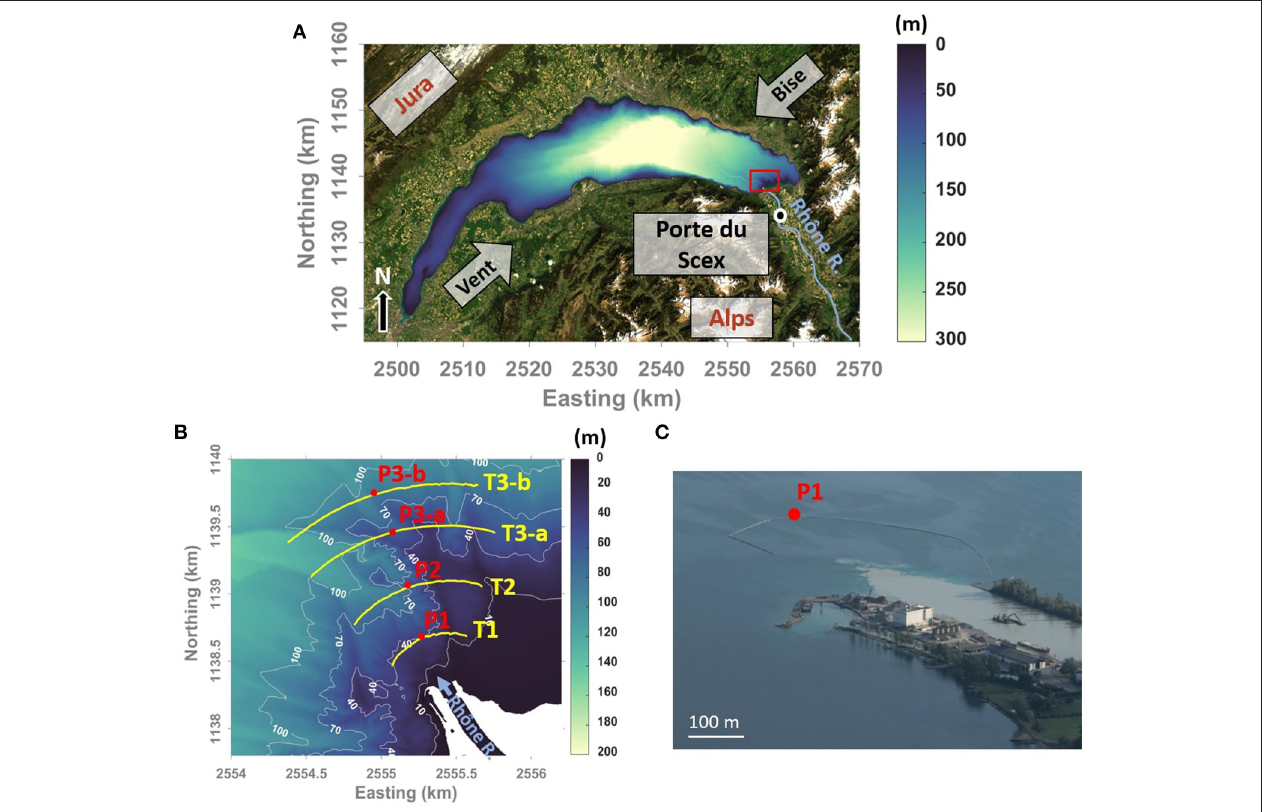
FIGURE 1 | (A) Bathymetric map of Lake Geneva also showing the mountain chains, Jura and Alps, that channel the strong dominant winds called Vent and Bise over most of the lake surface. The FOEN hydrological survey station at Porte de Scex on the Rhône River is marked by a white circle. The small red box approximately delimits the study site located in front of the Rhône River mouth. (B) Zoom of the study site where the Rhône River enters the lake. The yellow lines show the ADCP transects (T1, T2, T3-a, and T3-b). Red dots indicate the stations (P1, P2, P3-a, and P3-b) where the CTD and LISST profiles were taken. The Swiss coordinate system (CH1903 + ) is used (Swiss Federal Office of Topography, http://www.swisstopo.admin.ch, last accessed 12 June 2021). (C) Image of the Rhône River plume entering Lake Geneva. Due to the sediment load, the plume is turbid and appears light colored in the image; it plunges shortly after entering the lake. Note the triangular plunge region that indicates lateral plume slumping. Station P1 is